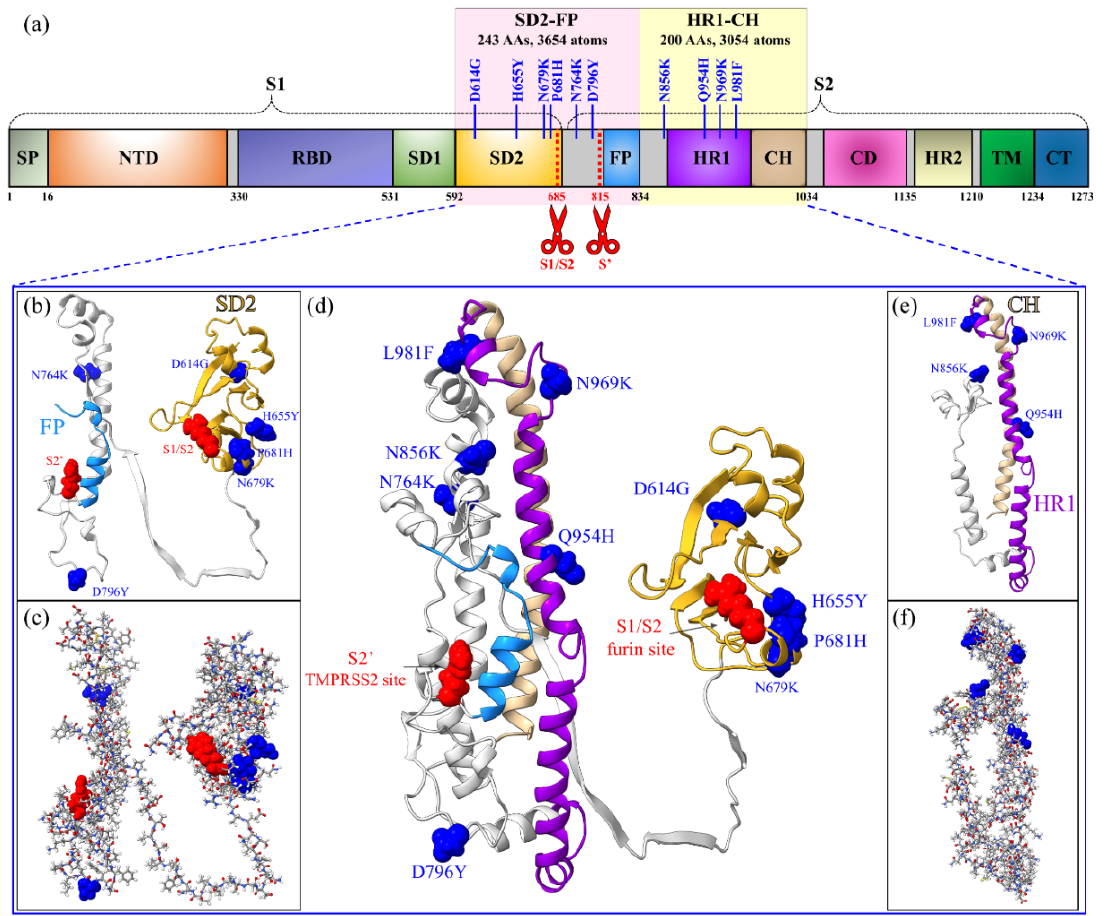
Figure 1. Graphic illustration of SD2-FP and HR1-CH models. ( a ) Schematic of S-protein primary structure divided into domains with cleavage sites S1/S2 and S2’ denoted by scissors and highlighting the SD2-FP and HR1-CH regions with their 10 Omicron mutations. ( b , c ) SD2-FP models in ribbon and ball and stick representations, respectively. Their six Omicron mutations are marked and